Question: Compose a caption that would accompany this figure in a paper.
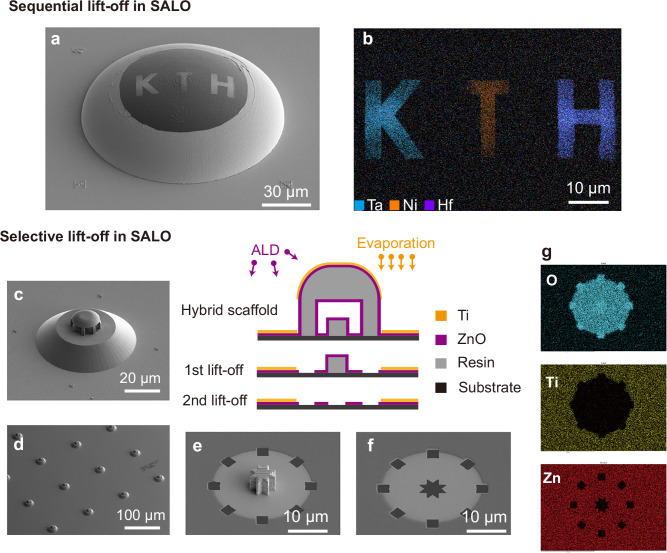
Answer: Sequential and selective SALO processes. a , b Sequential SALO patterning of multiple thin-film materials (Ta, Ni and Hf) on curved 3D surfaces (repeat scaffold printing, thin-film deposition, and lift-off). a SEM image of a 3D surface with the patterned letters ‘KTH’, each letter patterned in a different thin-film material. b Corresponding EDS map showing that each letter consists of a different thin-film material (Ta (cyan) for “K”, Ni (orange) for “T”, and Hf (purple) for “H”). c Selective SALO using hybrid scaffolds with different aspect ratios, combined with a conformal (ALD) and a directional (evaporation) coating. Sequential lift-off is achieved by selectively removing scaffolds of different aspect ratios by tuning the sonication power. d Hybrid scaffold array. e Pattern after the 1st lift-off. f pattern after 2nd lift-off. g EDX maps for O, Ti and Zn confirm the patterned SiO₂ substrate, 20 nm evaporation Ti layer and 20 nm ALD ZnO layer, respectively.